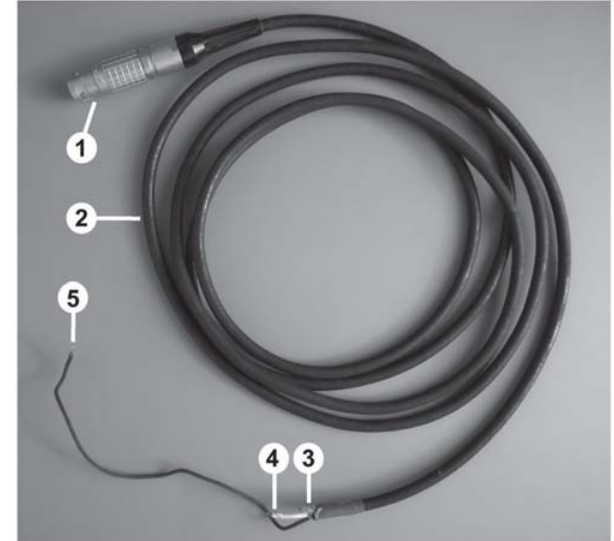
Fig. 3. Dipole construction for Electric Fish Finder. 1, dipole connector; 2, microphone cable; 3, exposed ground stub; 4, channel-1 unraveled from within cable, cut short, and copper wire exposed only at end; 5, channel-2 with longer length exposed. The dipole is mounted on a pole with duct tape in the field (Fig. 4).